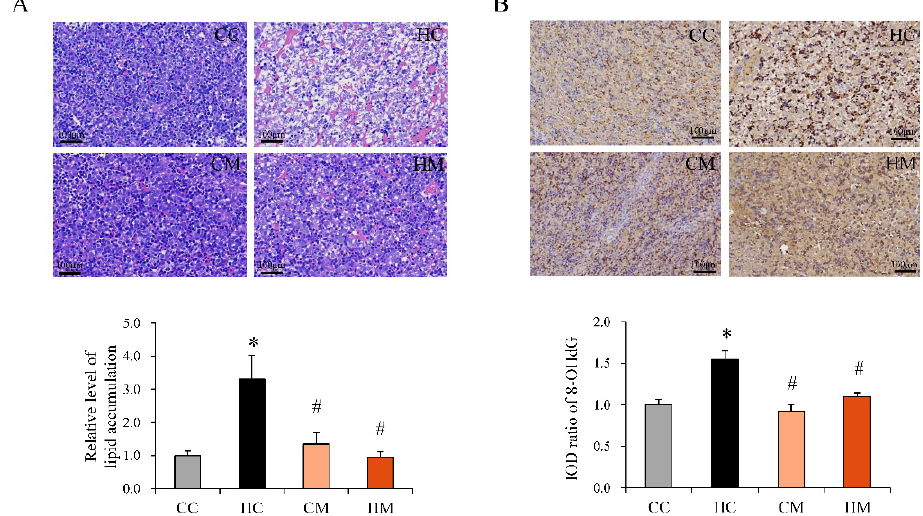
Figure 5. Histological manifestations of the fetal liver with a maternal high-fat diet and prenatal metformin treatment. ( A ) The extent of fetal hepatic steatosis is illustrated as vacuolation in the H&E stain. ( B ) The fetal liver oxidative stress was determined with 8-OHdG staining. Study groups: a maternal control diet (CC), maternal high-fat diet (HC), maternal control diet with metformin treatment (CM), or maternal high-fat diet with metformin treatment (HM). * Compared to the CC group, p < 0.05; # compared to the HF group, p < 0.05. Abbreviation: 8-OHdG, 8-hydroxy-2-deoxyguanosine; IOD, image optical density.